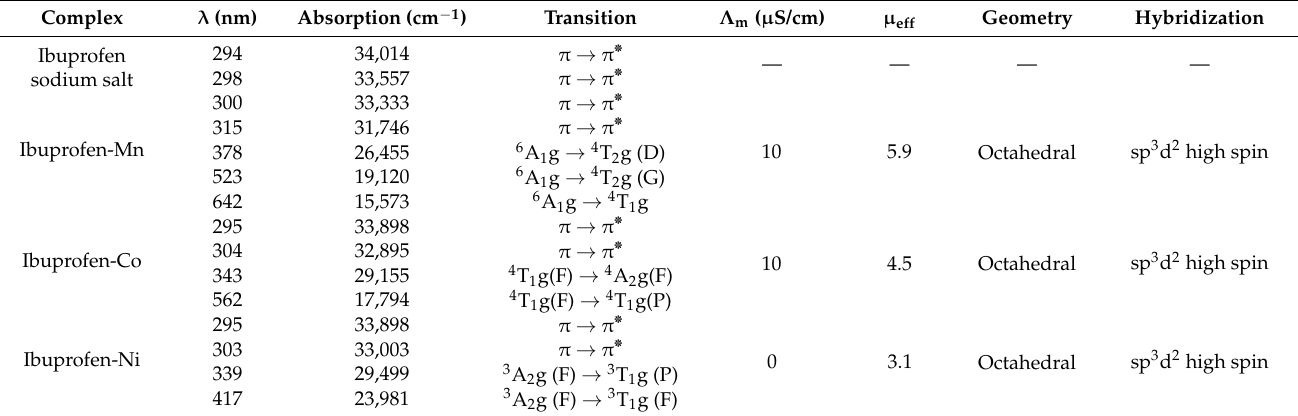
Table 3. Electronic spectral data, conductivity, magnetic moments, geometry, and hybridization of ibuprofen sodium salt and metal complexes obtained according to Scheme 1.